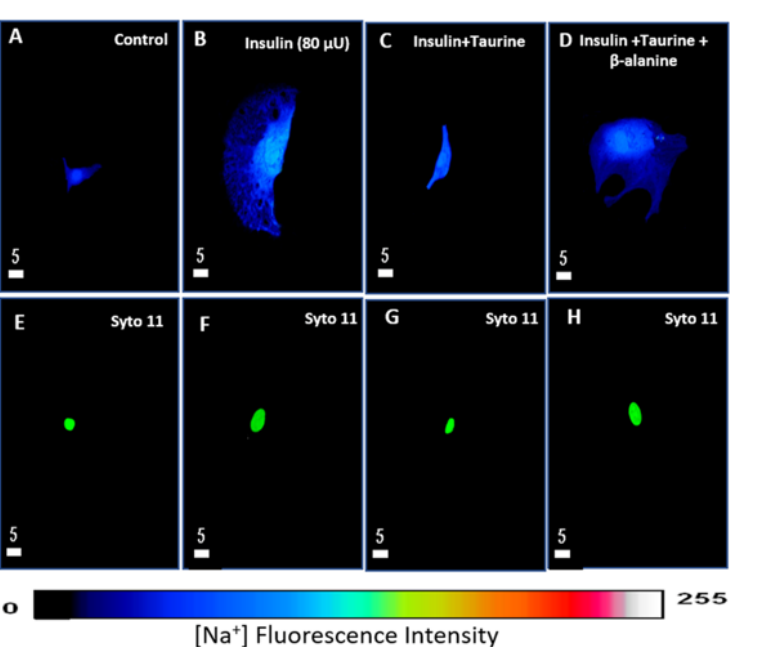
Figure 5. Histograms showing the effect of 48-h treatment with insulin (80 μ U/mL), insulin (80 μ U/mL) with taurine (20 mM), or insulin (80 μ U/mL) with taurine (20 mM) and β -alanine (500 μ M) on whole-cell ( A ), cytosolic ( B ), and nuclear ( C ) sodium levels of cardiomyocytes. The values are represented as mean ± standard error of the mean. N represents the number of animals, and n rep- resents the number of cells. * p < 0.05, ** p < 0.01, and **** p < 0.0001. Cont = control; ins = insulin; tau = taurine, and B = β -alanine. Sodium relative concentration is expressed in μ m 3 .